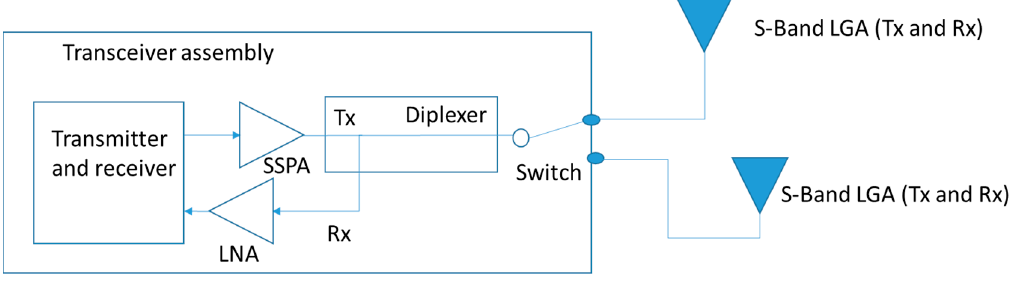
Figure 1. ASTERIA block diagram.